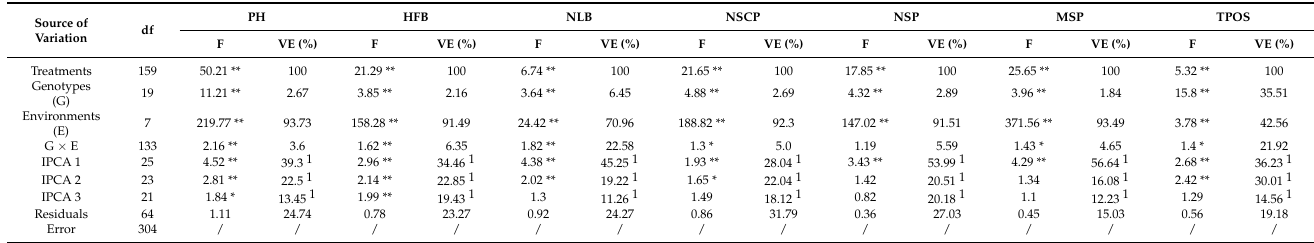
Table 4. Additive main effect and multiplicative interaction (AMMI) analysis of variance in traits of camelina genotypes across eight environments.